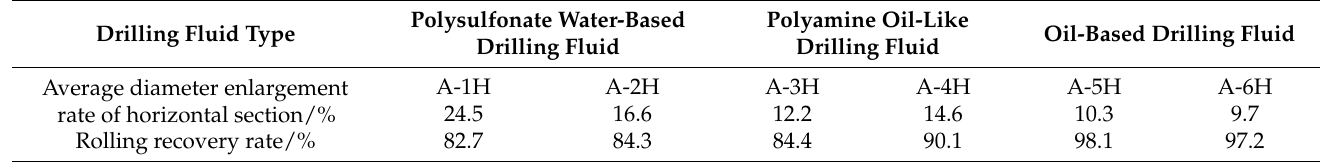
Table 7. Comparative analysis of the hole diameter expansion rate of oil-based drilling fluid and water-based drilling